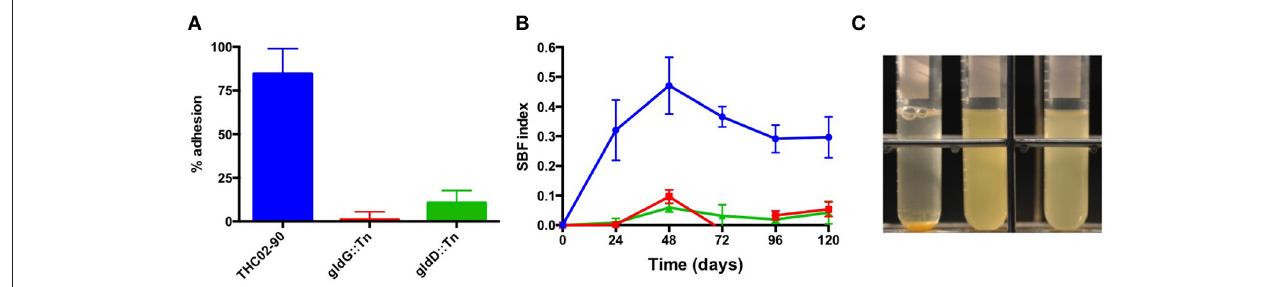
FIGURE 3 | Adhesion, biofilm formation, and sedimentation. (A) Adhesion of the F. psychrophilum strains THCO2-90 (blue), gldG::Tn (red), and gldD::Tn (green) to polystyrene after 3h of incubation at 18 ◦ C without shaking. (B) Biofilm formation kinetic of the same strains (same color code) grown in 1/2 TYES broth for 120h at 18 ◦ C without shaking. (C) Bacterial cells sedimentation of strains THCO2-90 (left); gldG::Tn (center) and gldD::Tn (right) grown in TYES broth after 48h at 18 ◦ C, 200 rpm. The results are representative of three independent